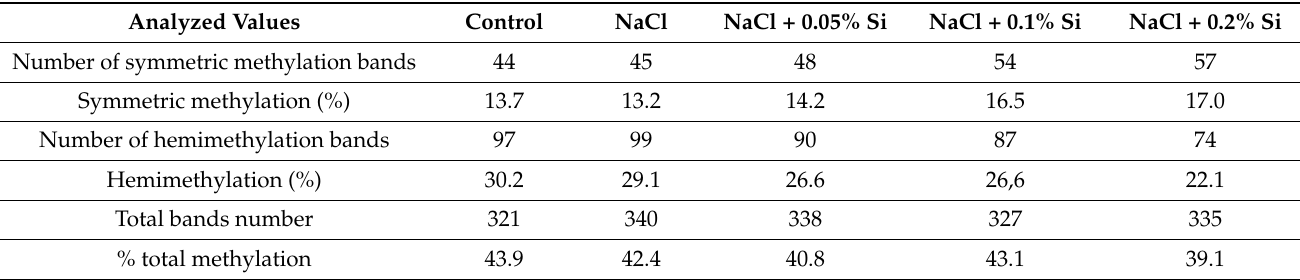
Table 2. The results of methylation